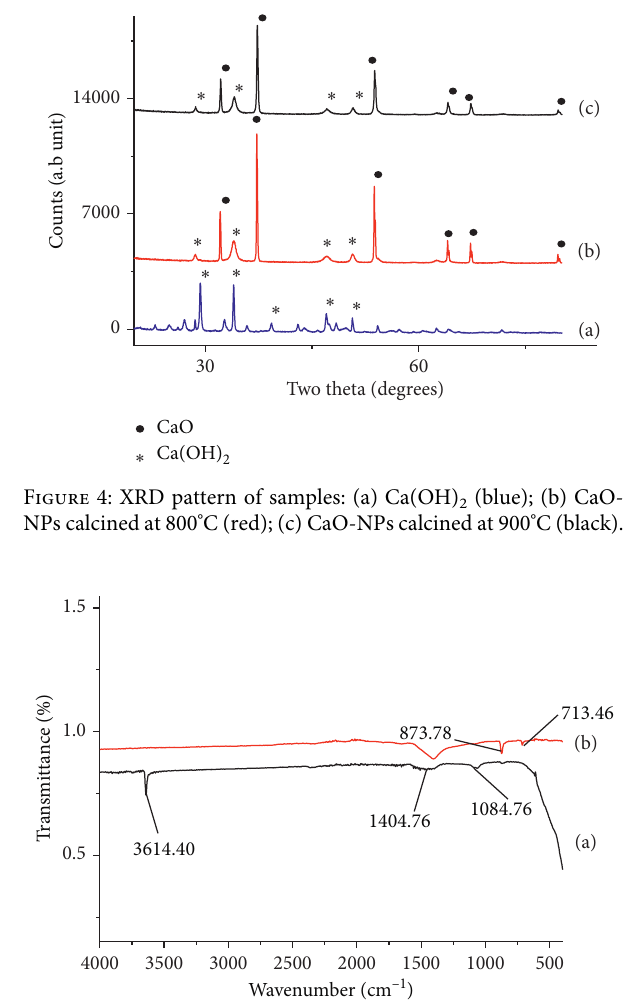
Figure 5: FTIR spectra of (a) chicken eggshell (black) and (b) chicken eggshell ash-derived CaO calcined at 800 ° C